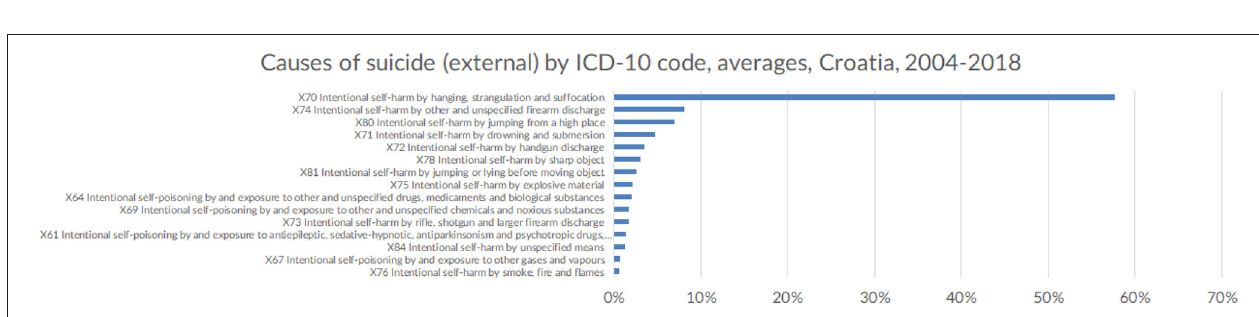
FIGURE 8 | Causes of suicide (external) by ICD-10 code, in Croatia (averaged across the observed period), 2004-2018 (Croatia,